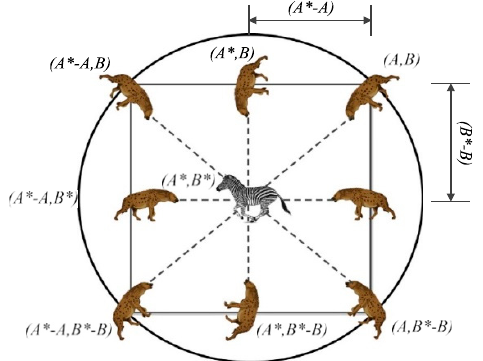
Figure 4. Two dimensional position of spotted hyena.